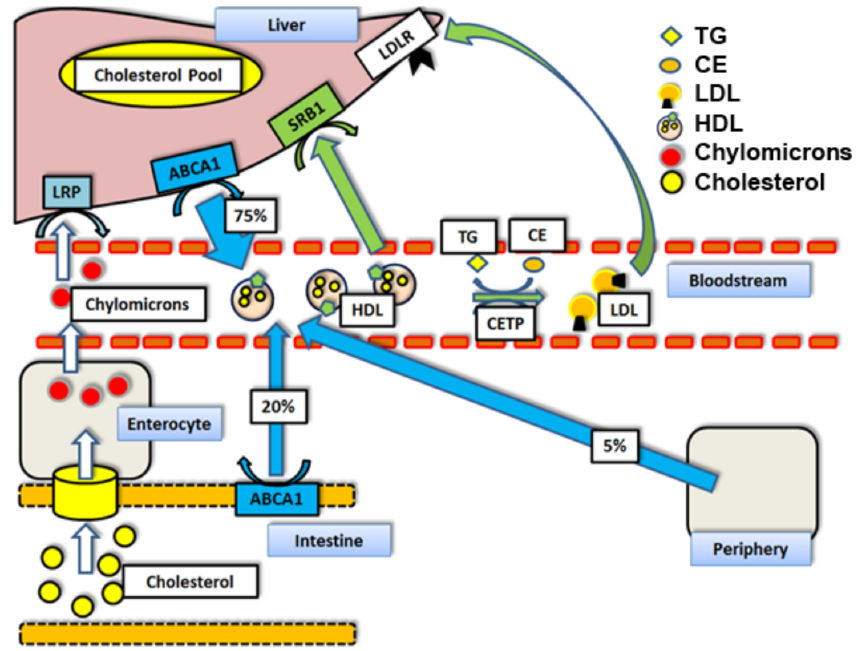
Figure 1. Reverse Cholesterol Transport mechanisms and respective contributions to HDL cholesterol loads by percent [10]: Abbreviations: TG = triglycerides. HDL = high density lipoprotein particle. CETP = cholesteryl ester transfer protein. LDL = low density lipoprotein particle. ABCA1 = ATP binding cassette transporter A1. LDLr = Low density lipoprotein receptor. LRP = LDLr receptor-related protein. SR-BI = scavenger receptor class B type I. CE = cholesteryl ester.